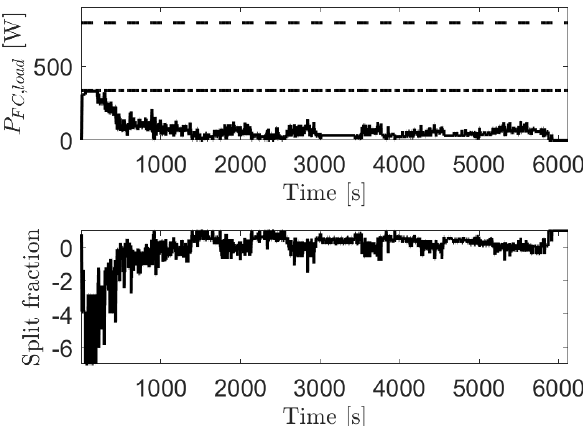
Figure 13. Fuel cell load demand power and split fraction versus time, Simulation Scenario II. The dashed and dashed-dotted lines in the top figure indicate the maximum P FC with γ and = 20 deg, | |